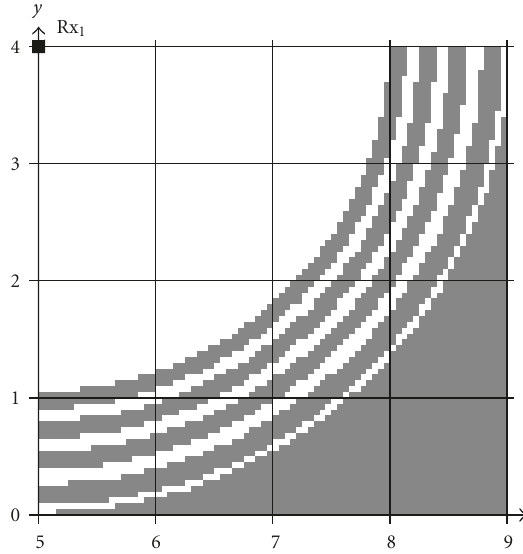
Figure 7: I (1,3) : showing the influence of the discrete nature of transmit power on connectivity between Tx 1 and Rx 1 in the sense of Property 1; ( Δ a , Δ b ) = (0 . 0625m,0 . 0625m).